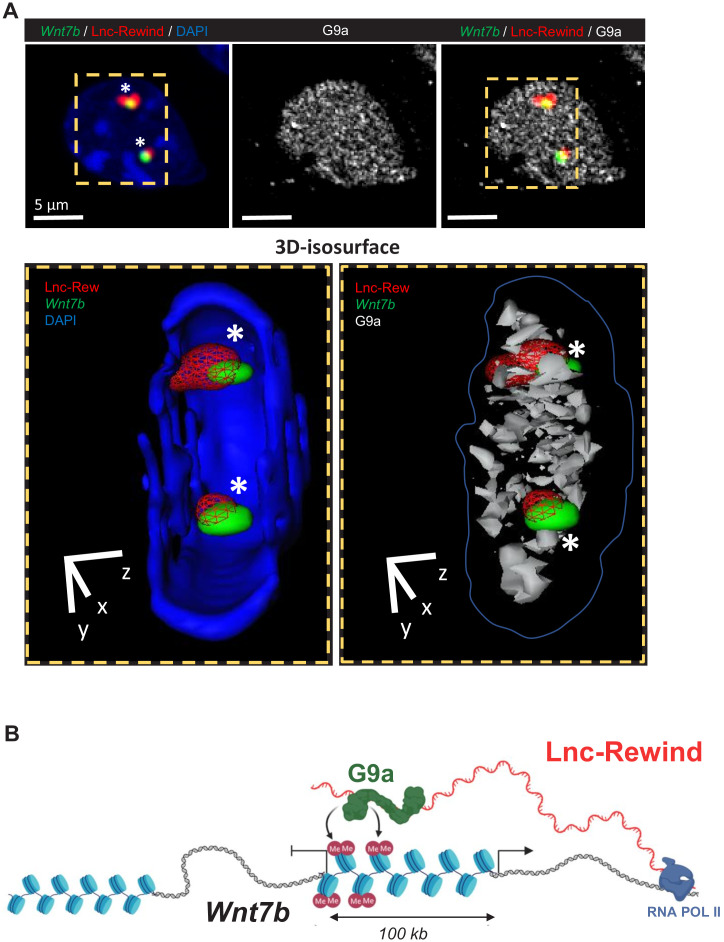
Lnc-Rewind and G9a colocalize on Wnt7b gene locus.(A) Top panel: RNA/DNA-FISH combined with immunofluorescence performed on MuSC-derived myoblasts; Lnc-Rewind RNA (red), Wnt7b DNA locus (green), and G9a protein (grey) are shown. Bottom panel: Isosurface rendering of nuclear sections is indicated by the yellow dashed lines. The overlapping regions between Lnc-Rewind (RNA) and Wnt7b (DNA) locus (left) and among Lnc-Rewind, Wnt7b locus, and G9a (right) are indicated by the white asterisks inside the nuclear volume. (B) Proposed model for the functional interplay between Lnc-Rewind and G9a on Wnt7b gene locus. Representation of mmu_Lnc-Rewind mode of action in muscle cells. In proliferating myoblasts, the Lnc-Rewind transcript is expressed, recruits the silencing methyltransferase G9a on the locus that represses Wnt7b transcription.